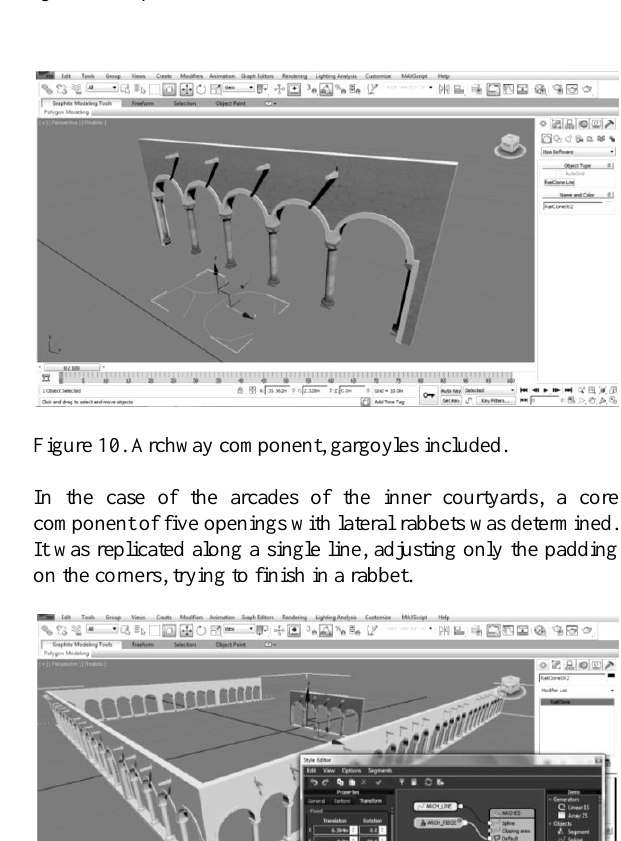
Figure 8. The same style applied on a one-story-colonial-facade.